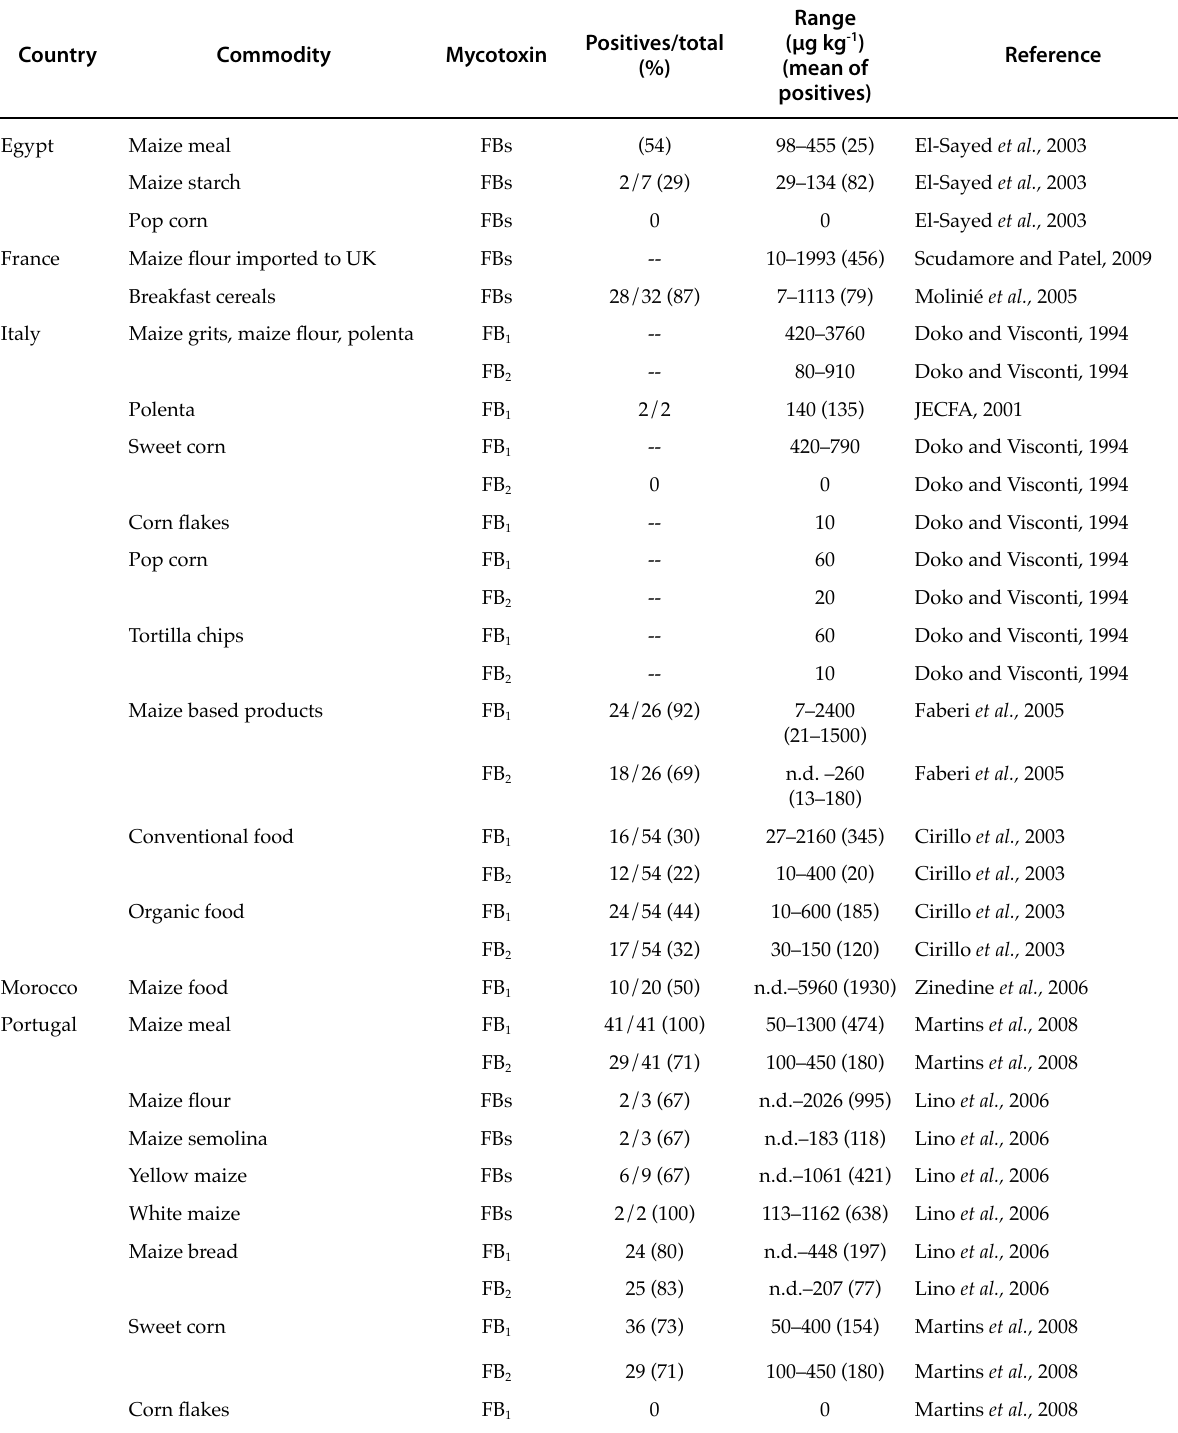
Table 9. Occurrence of fumonisins in maize-based food from Mediterranean countries intended for human consumption. Country